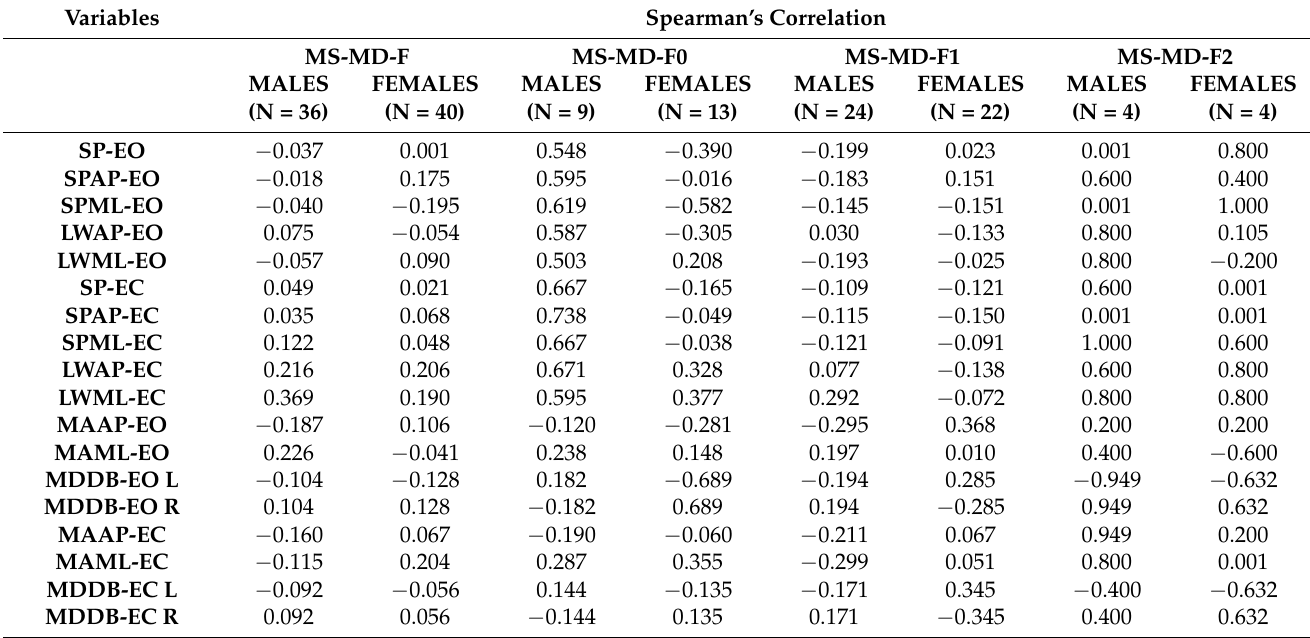
Table 5. Sex differences in the correlations between the results of stabilometric platform/static postural control and body mass in MS